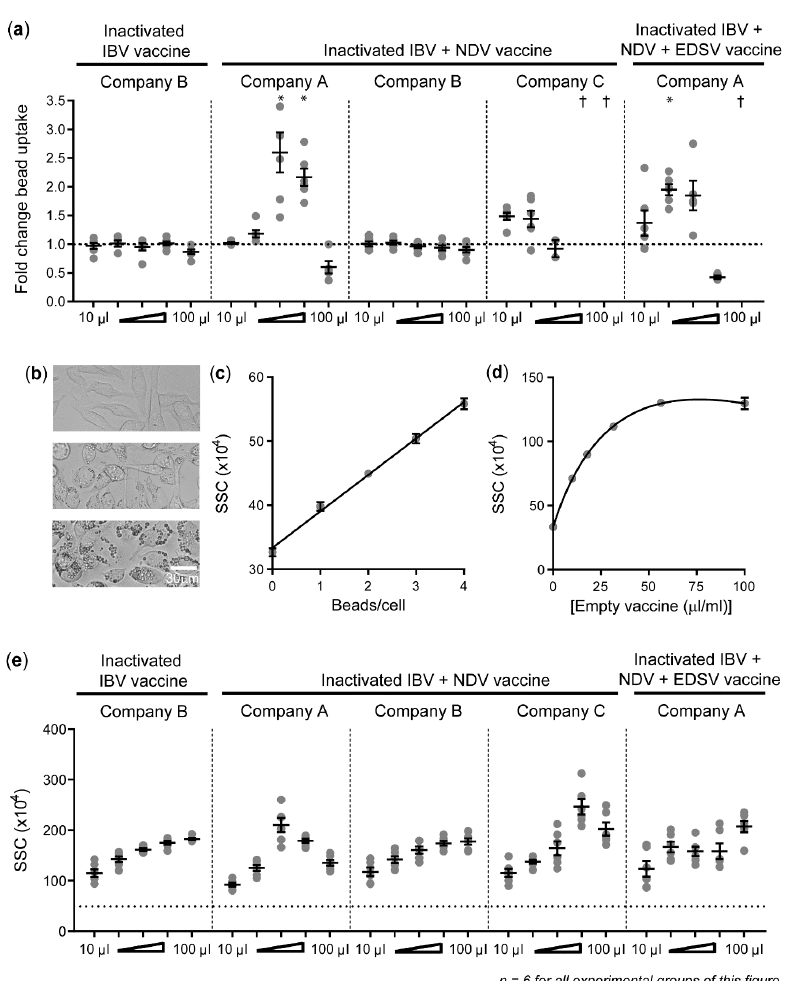
Figure 4. Phagocytosis capacity of HD11 cells can be increased upon exposure to inactivated viral w / o vaccines. ( a ) The fold change in bead uptake by HD11 cells upon stimulation with vaccines is compared to unstimulated controls. The x -axis shows the graded doses at which the vaccines have been added, expressed as µ L dose, added to 1 mL of cell culture medium. † indicates that datapoints were missing because the threshold of ≥ 100 viable cells was not reached. (b) Light microscopy photos show unstimulated HD11 cells (top), HD11 cells exposed to 10 µ L / mL inactivated bivalent vaccine B (middle), and 100 µ L / mL inactivated bivalent vaccine B (top). (c) A linear correlation curve shows the relationship between the average flow cytometric SSC and number of IgY-opsonized beads / cell for HD11 cells containing 0–4 beads / cell. (d) A non-linear saturation curve shows the relationship between the average SSC and di ff erent doses of empty vaccine (without viral antigens) from company B. (e) The flow cytometric SSC of HD11 cells is shown for graded doses of the di ff erent vaccines. Three independent experiments were performed, and the experimental conditions of each independent experiment were tested in duplicate. Error bars represent the SEM. The experimental groups were tested for statistically significant di ff erences in bead uptake and SSC between stimulated and unstimulated groups using Kruskal–Wallis tests and Dunn’s multiple comparisons tests. Statistical significance is indicated by * p < 0.05. For figure (e), all data was found to be statistically di ff erent from the unstimulated sample with p <